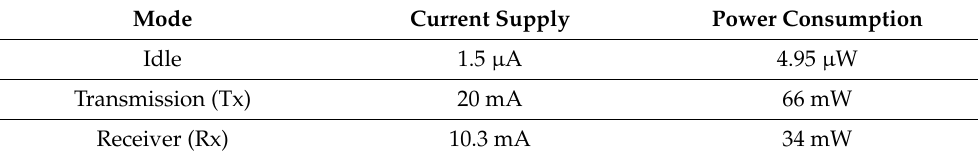
Table 6. Sx1276 Power characteristics.